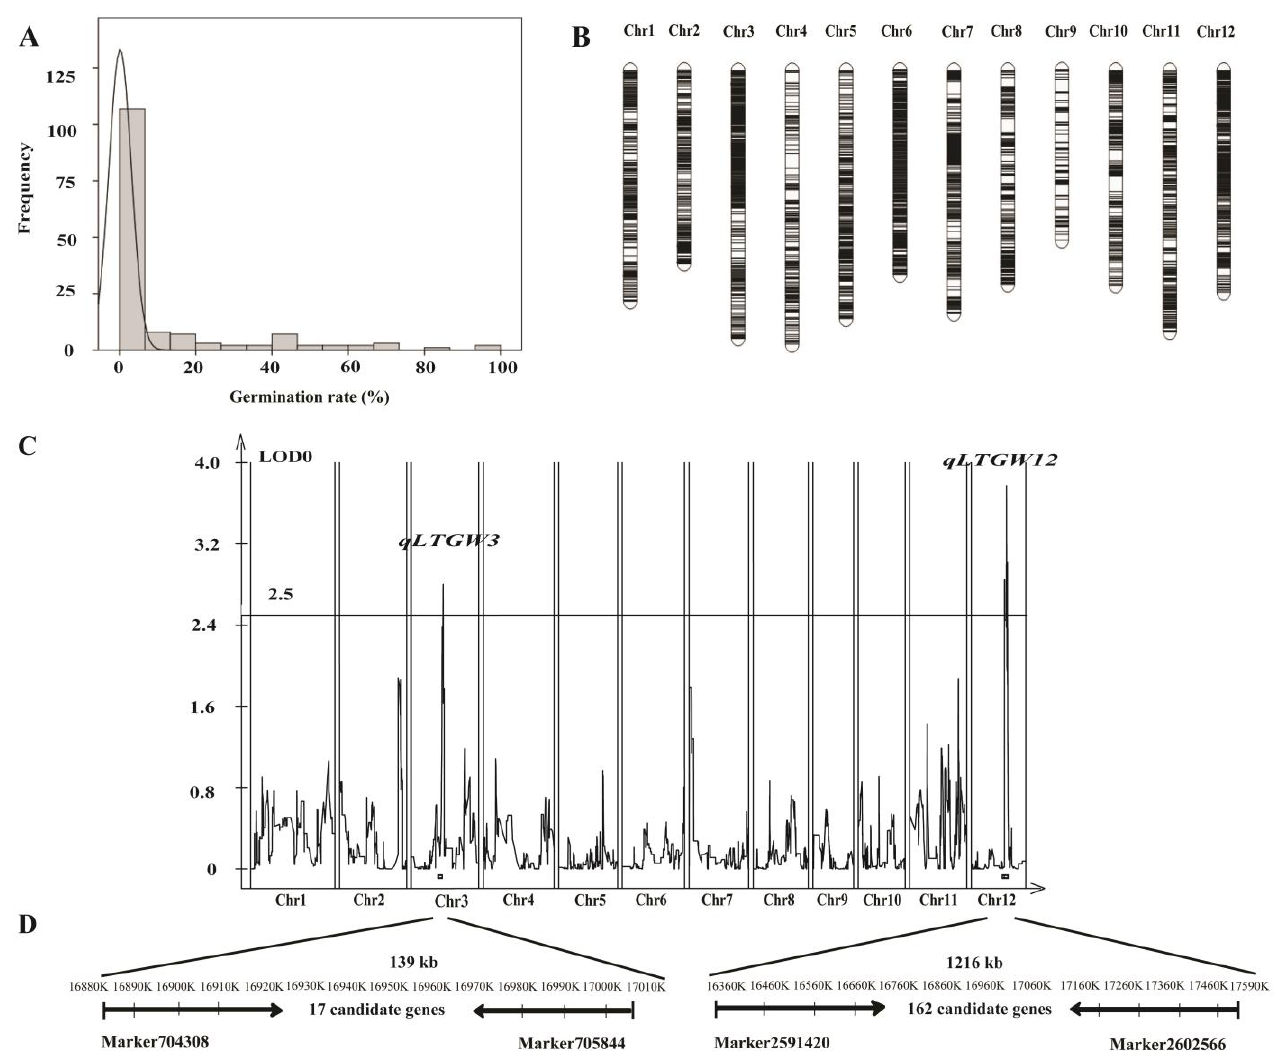
Figure 6. QTL mapping for the LTG. ( A ) The frequency distribution of LTG rates for the RIL popula- tion of WR04-6 × QSZ. ( B ) Genetic map of the RIL population constructed by WR04-6 × QSZ. Each black horizontal line is a marker. ( C ) QTL mapping of LTG in the RIL populations of WR04-6 × QSZ. ( D ) The QTL was narrowed down to a 139 kb region on chromosome 3 and a 1216 kb region on chromosome 12.